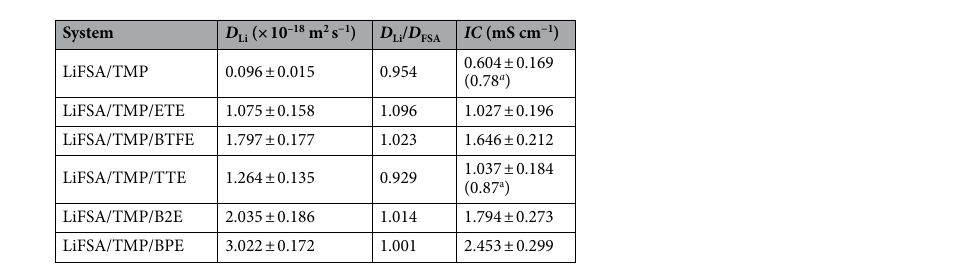
Table 3. Transport properties of highly salt-concentrated electrolyte LiFSA/TMP system and 5 different diluted LiFSA/TMP based electrolyte systems at 298 K. a Ref. 12